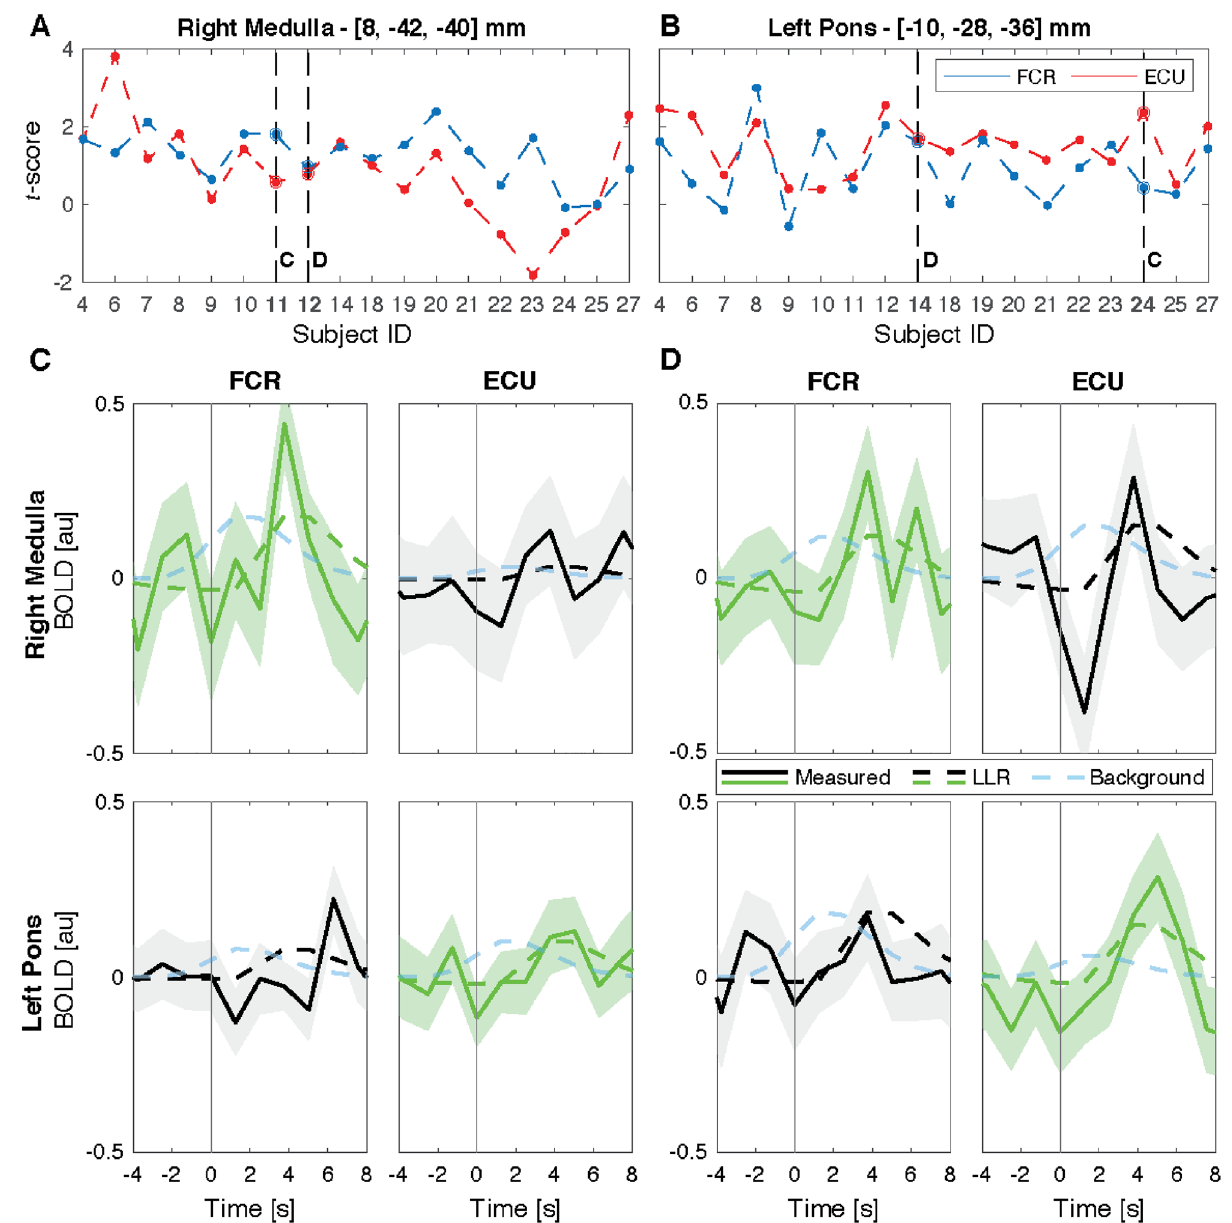
Figure 6. ( A , B ) Participant-specific t scores obtained for the FCR and ECU activation in the two most significant clusters at the group level in the right medulla ( A ) and left pons ( B ). Dashed lines indicate the subjects that have been selected for the timeseries analysis. Specifically, the participants labeled with ( C ) showed the greatest difference between the statistical scores specific to the FCR and ECU regressors, while the participants labeled with ( D ) showed similar t score for the two regressors. ( C , D ) Average BOLD signal measured in response to muscle stretch in the selected voxels, for the respective participants, as marked in ( A ) and ( B ). In all graphs, the solid line shows the average residual BOLD response after variance associated to nuisance regressors is removed, while the shaded area represents the 95% confidence interval of the mean response. Dashed lines show the average modeled response respectively for the LLR-specific regressors (green or black line), and for the background-specific regressor (light blue line), in each respective participant. Modeled response for the LLR-specific regressor was scaled based on the appropriate β coefficient estimated by the GLM model, while modeled background response, which is not included in the primary GLM, was arbitrarily scaled to match the same amplitude of the LLR-specific regressor. Measured and LLR-specific signals are then color- coded to distinguish the response that is significant at the group level for that specific muscle (green), from the one that is not significant